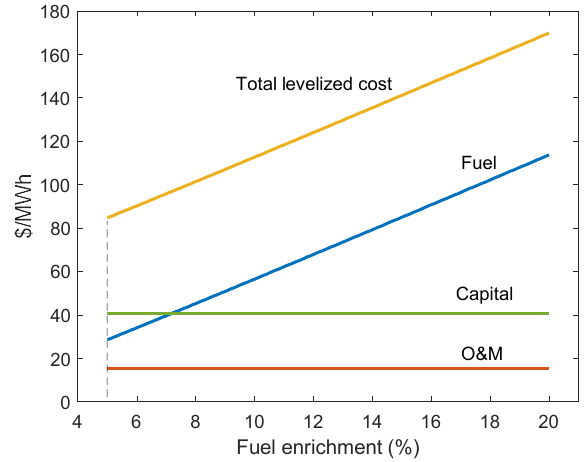
Figure 9. NB levelized electricity costs vs. fuel enrichment.